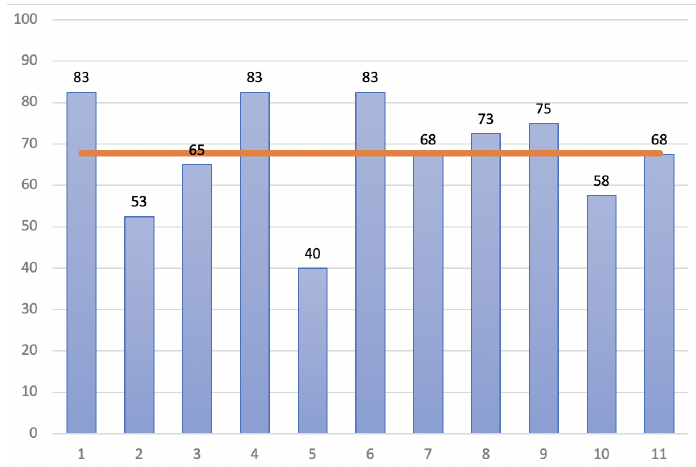
Figure 5. Graphical representation of the SUS scores, for the odds items, even items and grades obtained for each participant along the average one (represented by the orange line). Table 2. Tabular representation of the SUS scores, for the odds items, even items and grades (as explained in Figure 4) obtained for each participant along the average